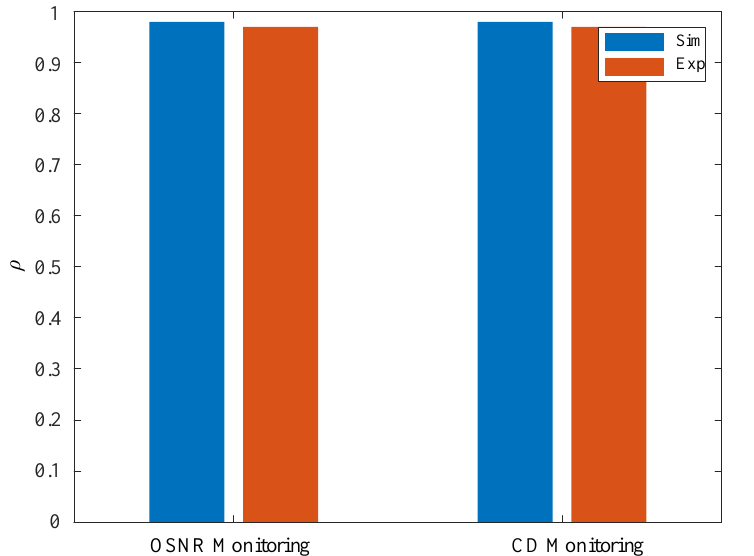
Figure 18. Simulation vs. experimental results for monitoring OSNR and